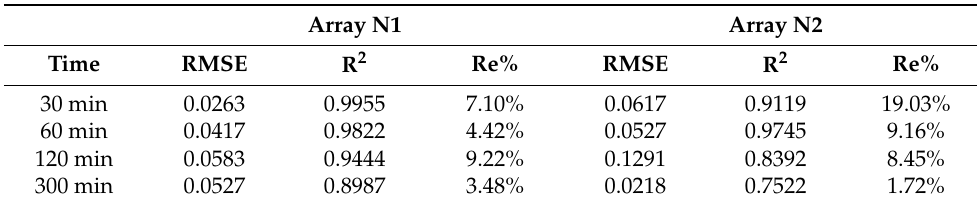
Table 2. Accuracy of the vertical simulation of solute concentrations at different monitoring points and periods.